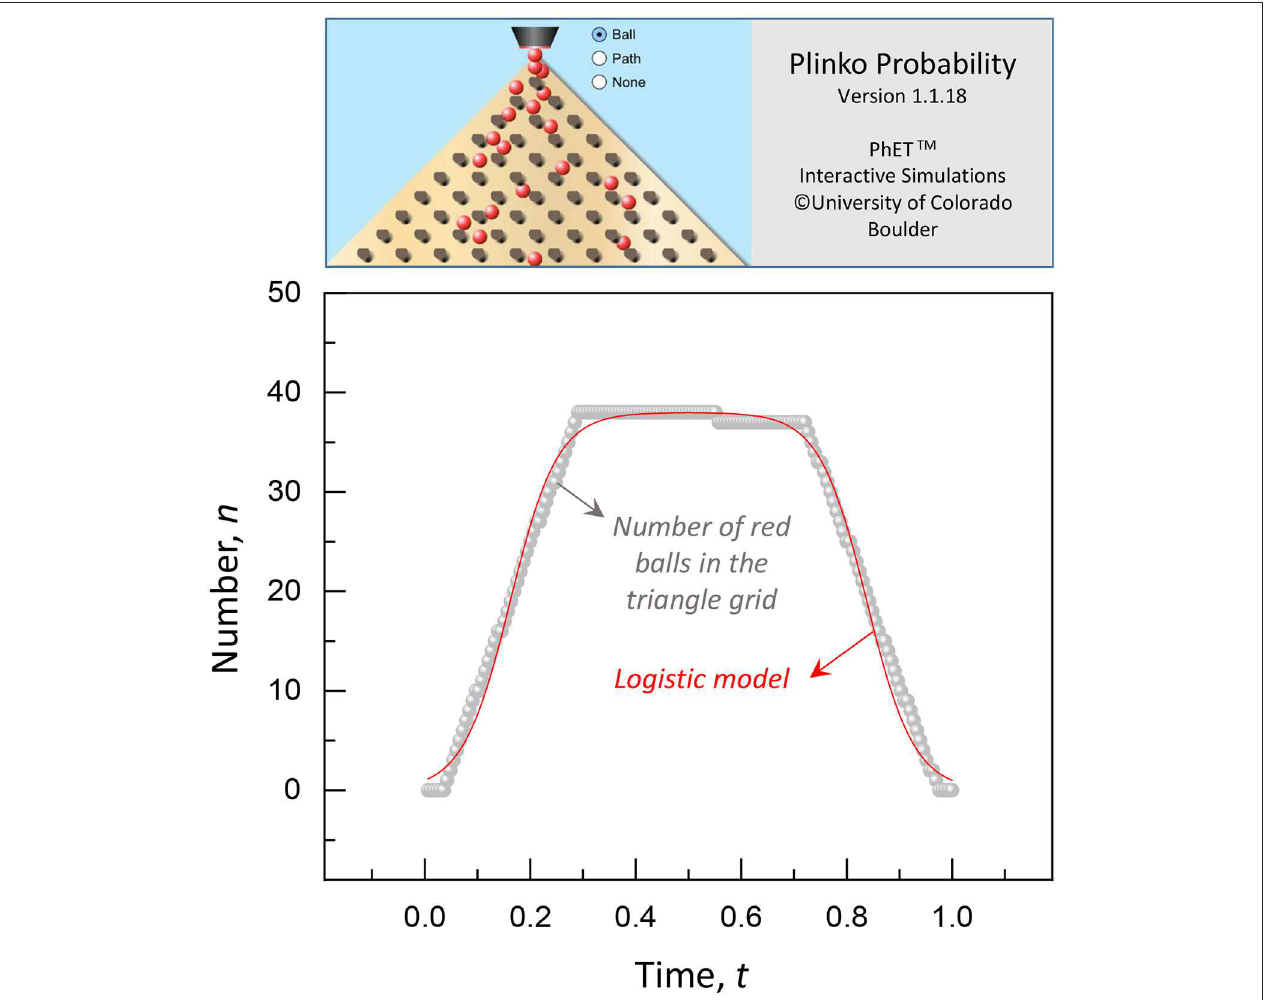
FIGURE 3 | Simulation of falling balls through a triangle grid of pegs for the Plinko Probability by the PhET interactive simulations ( Movie S1 ). The number of red balls in the triangle grid increases with time at t < g and decreases with time at t > g , showing a good agreement with the logistic model with a = 1.0, b = 0.135, c = 38, d = 42.2, and e = 165 ( N / c =